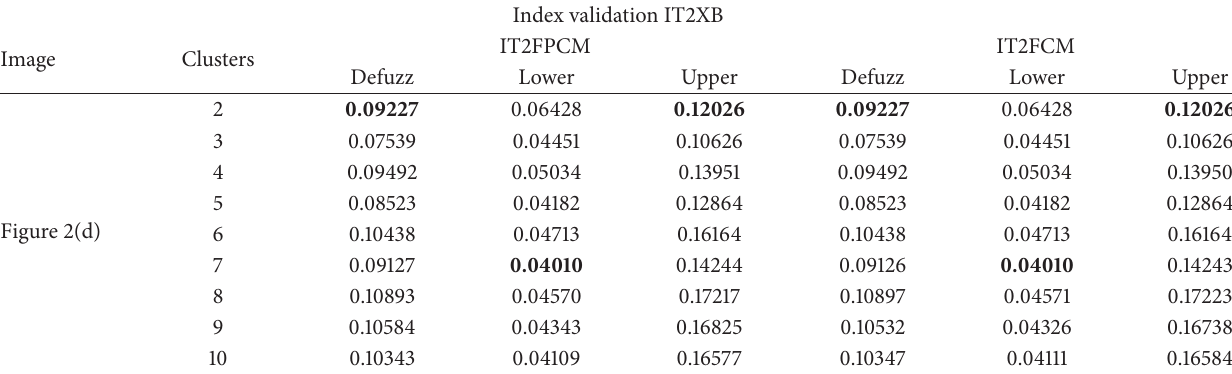
Table 39: Results of the IT2XB validation index to the clustering of image shown in Figure 2(d) using IT2FPCM and IT2FCM algorithm with 𝑚 = [1.5, 2.5] and 𝜂 = [1.5, 2.5] as parameters.